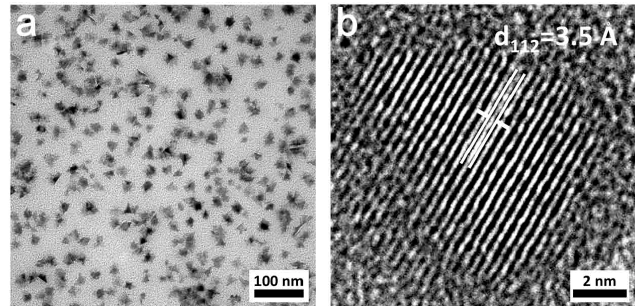
Figure 2. Transmission electron microscopy (TEM) ( a ) and high-resolution transmission microscopy (HRTEM) ( b ) of CuInTe 2 nanocrystals (2 mmol stearic acid).